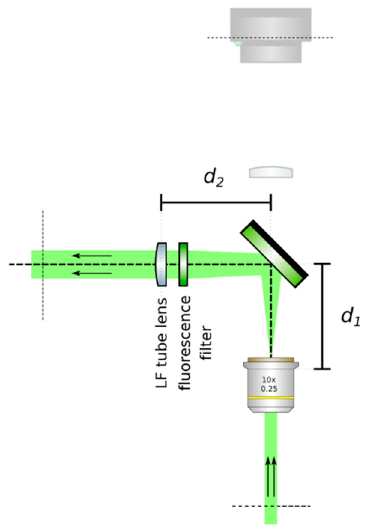
Figure 12. Insert the LF tube lens. Using collimated light, adjust the distance from the detection objective to the LF tube lens until a collimated beam results from the tube lens. This guarantees a 4 f configuration between the objective and the tube lens.